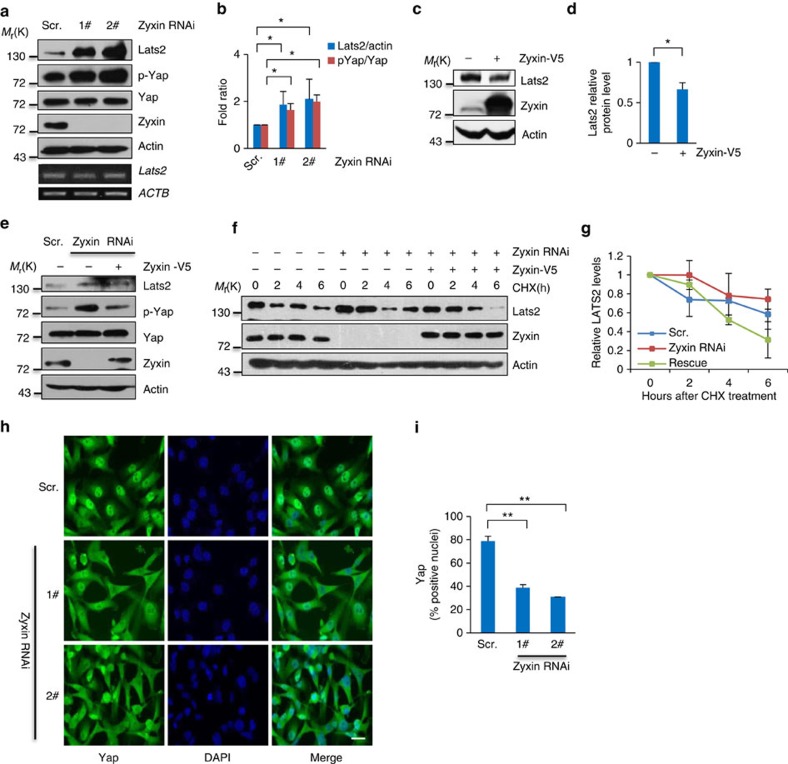
Loss of Zyxin stabilizes Lats2 and activates the Hippo signalling.(a,b) Cells stably expressed short hairpin RNA (shRNA) against Zyxin were collected for immunoblotting with indicated antibodies or by PCR with reverse transcription (RT–PCR) for the indicated genes (a) and quantification of Lats2 (normalized to actin) and p-Yap (normalized to Yap) protein levels (b). Ratio t-test was applied. (c,d) Cells transiently transfected with Zyxin for 24 h then were collected for immunoblotting with the indicated antibodies (c) and quantification of Lats2 (normalized to actin) protein levels (d). Ratio t-test was applied. (e) Zyxin-knockdown cells were transfected with wild-type Zyxin. Twenty-four hours later, cells were collected for immunoblotting with indicated antibodies. (f) Cells were transfected with Zyxin, treated with 100 μg ml−1 cycloheximide (CHX), collected at indicated the time points and then immunoblotted with the indicated antibodies. (g) Quantification of Lats2 protein levels (normalized to actin). (h) Zyxin-knockdown MDA-MB-231 cells were stained with 4,6-diamidino-2-phenylindole (DAPI) and antibody against Yap. Scale bars, 25 μm. (i) Quantitative analysis of Yap nuclear translocation. Student's t-test was applied. All data are mean of n=3 independent experiments. All error bars indicate s.d. *P<0.05; **P<0.01.